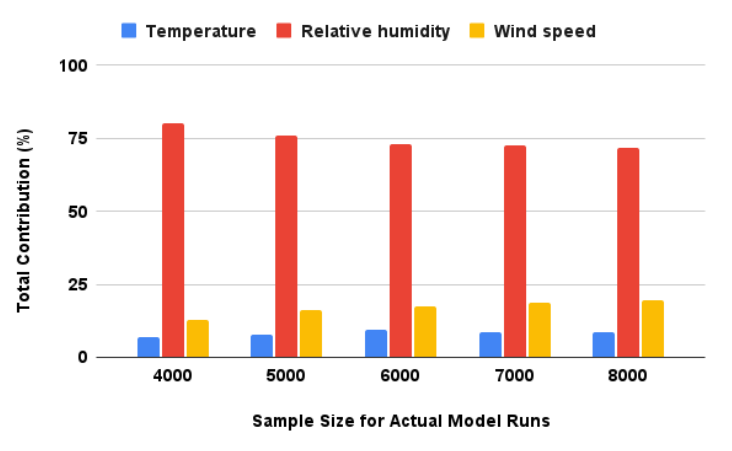
Figure 5. Sensitivity indices of fire size to input weather inputs estimated with true observations and Bayesian model estimated values. The sample size of 8000 represents the complete dataset with all true observations. Our application of Bayesian model-predicted values gave close-to-true estimations of the sensitivity indices using as few as 4000 true observations. As the number of true observations used in the estimation increased, the estimations improved in their closeness to the complete dataset of true